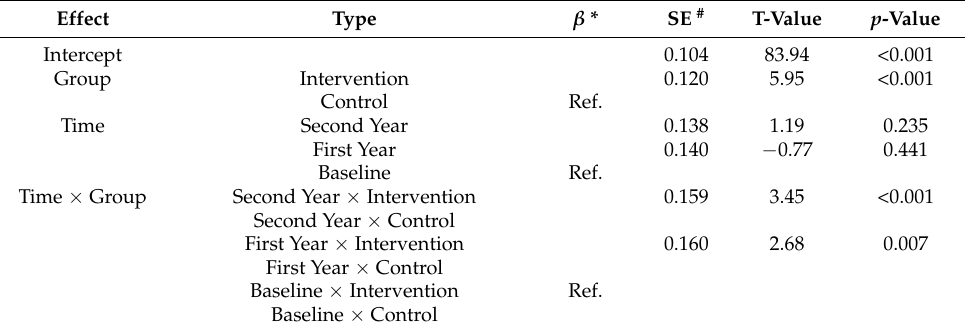
Figure 3. Changes in mean score for children’s dietary intake in first and second year from baseline. Vertical bars indicate standard deviations. Table 6. Test of the fixed effects of various factors of dietary intake